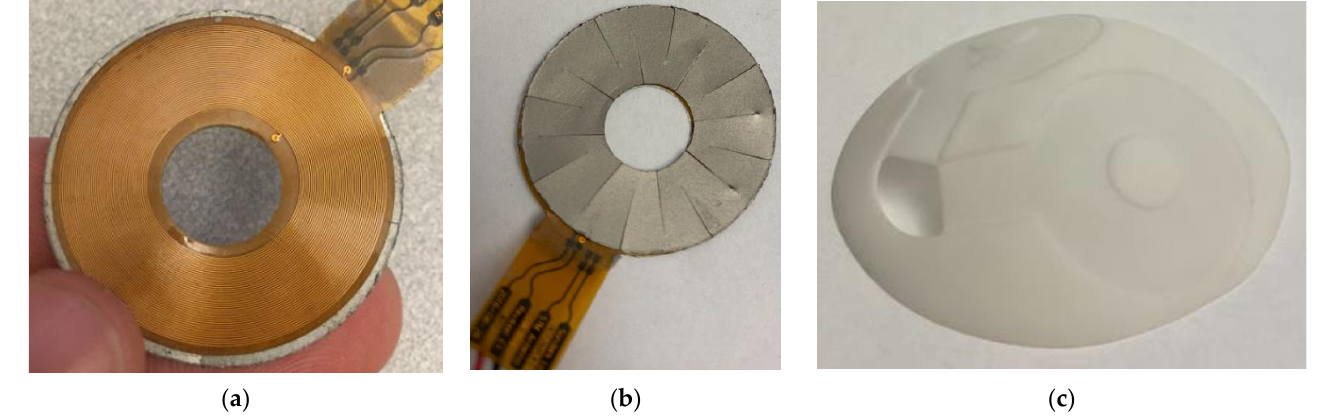
Figure 2. Sensor antenna. ( a ) Custom antenna with the center removed to improve flexibility. ( b ) A thin piece of ferrite is adhered to the external surface, and radial slits are made to improve flexibility. ( c ) Bottom view of a fabricated insert ready for antenna and leadwire attachment.